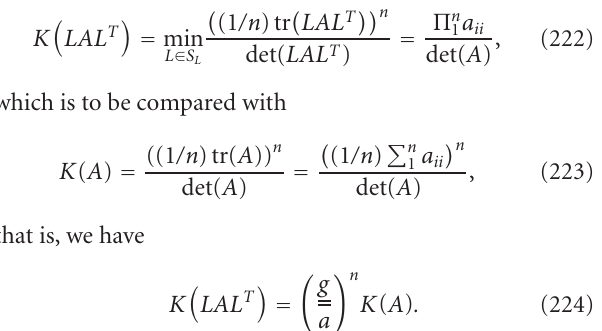
Algorithm 1 (Iterative refinement method). Given x (0) =